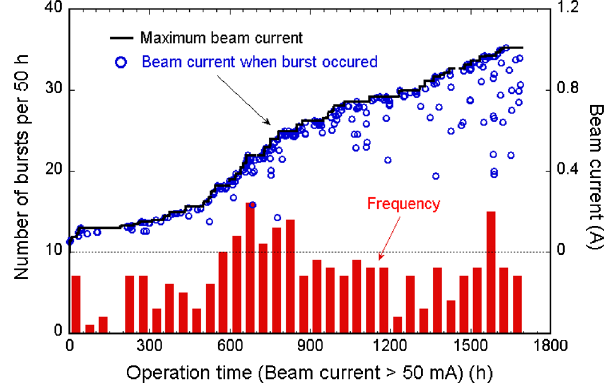
FIG. 13. Typical example of a pressure burst accompanying beam loss, followed by beam abortion.